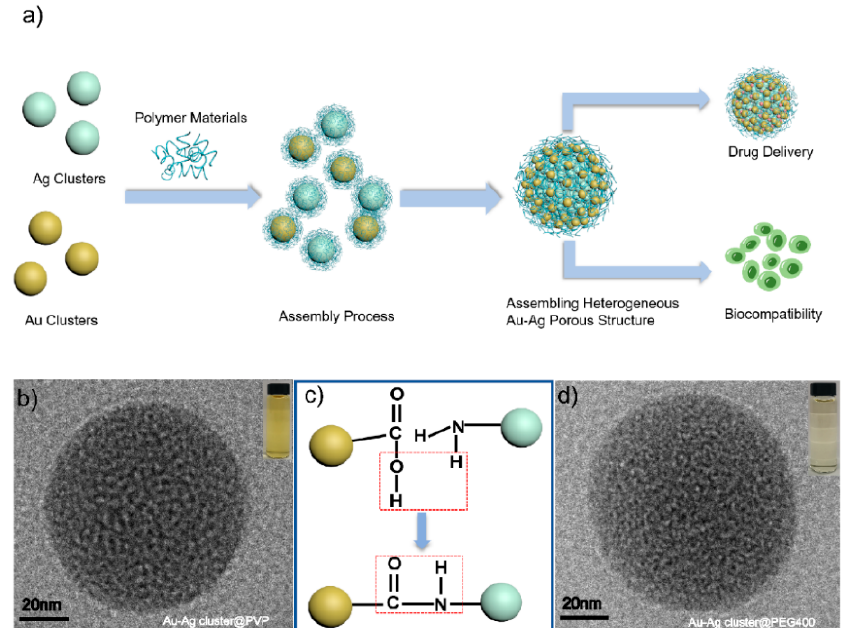
Figure 1. ( a ) Schematic diagram of formation and synthesis of heterogeneous assembly structures of precious metal NCs (Au, Ag); ( b )HR-TEM images of Au-Ag cluster @PVP; ( c ) Self-assembled mechanism of Au-Ag NCs and ( d ) HR-TEM images of Au-Ag cluster @PEG400.